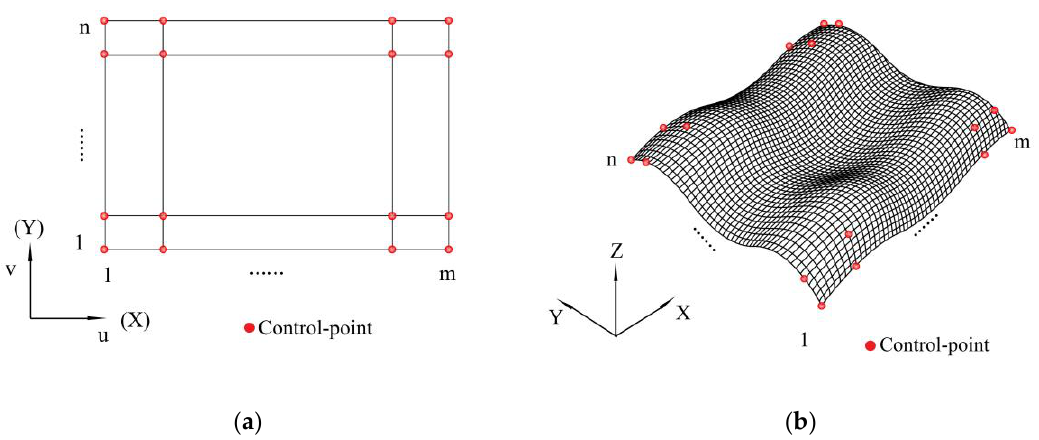
Figure 1. Example of a NURBS (Non-Uniform Rational B-Spline) surface: ( a ) Control-point grid; ( b ) Corresponding NURBS surface.